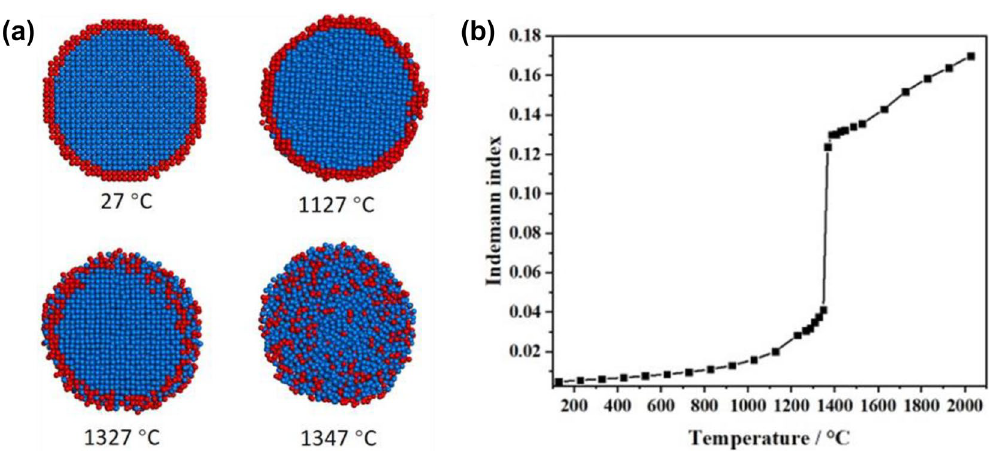
Figure 8. ( a ) Snapshots of Rh–Ir NP taken at four representative temperatures during the heating process and ( b ) the Lindemann indices. Coloring denotes type of atom: red, Ir atom; blue, Rh